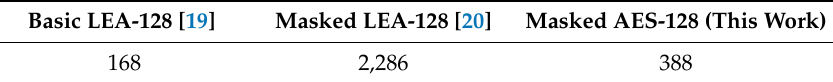
Table 3. Evaluation of LEA (Lightweight Encryption Algorithm) and AES implementations on